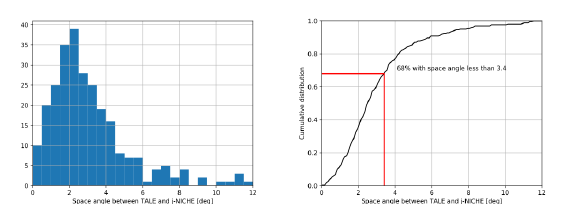
Figure 4. Left: The distribution of the di ff erence in space an- gle between TALE PCGF fits and NICHE Plane fit. Right: The normalized integral of the space angle